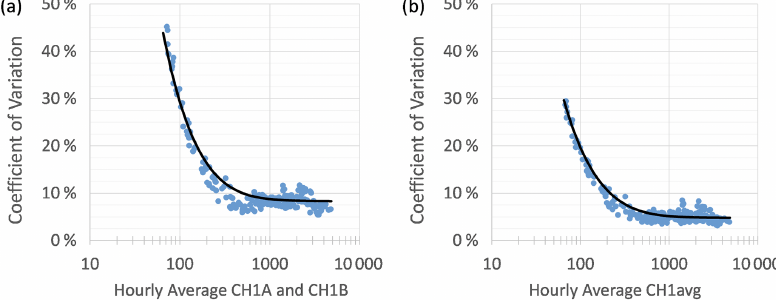
Figure 2. Precision estimated as the coefficient of variation of the hourly CH1A and CH1B (a) and CH1avg values (b) for the 19 collocated sensors and 9 PA-PMSs.